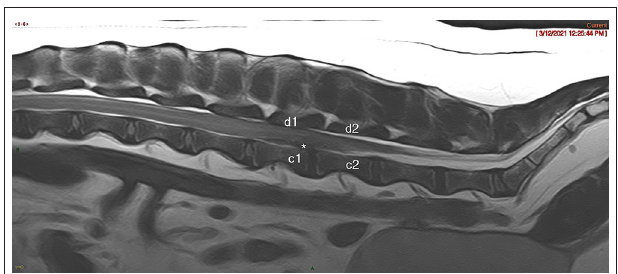
FIGURE 1 | T2w Sagittal MRI image showing spinal compression count noted as “c” and surgical decompression count noted as “d.” This patient had a compression:decompression ratio of 1. An * denotes representative areas of intervertebral disk herniation.